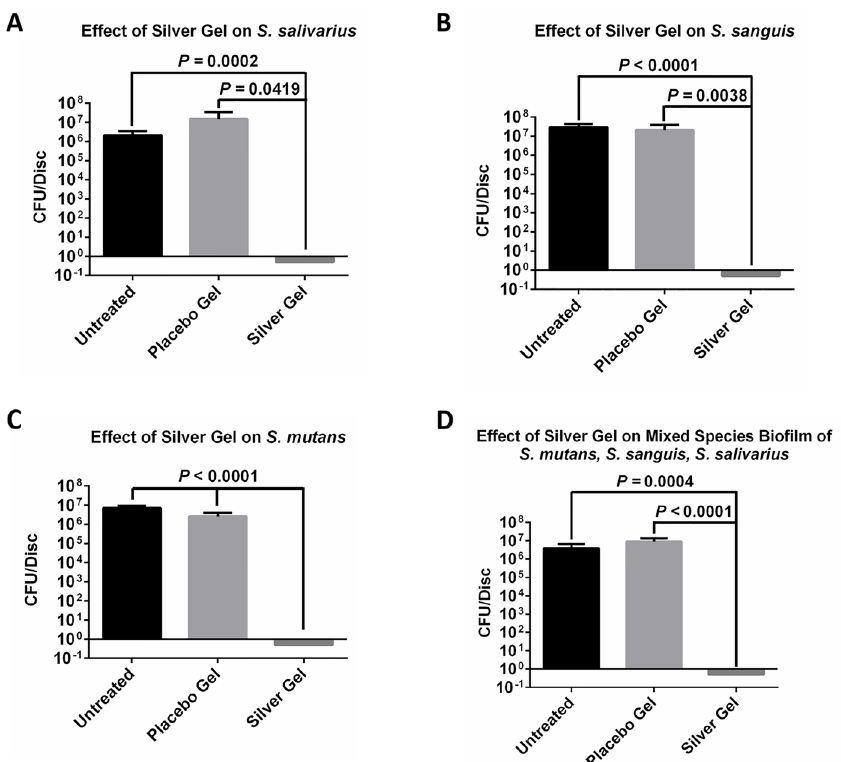
Figure 1. Colony forming unit analysis of biofilm formation. ( A ) S. salivarius , ( B ) S. sanguis, ( C ) S. mutans or ( D ) all three on untreated discs, discs treated with placebo gel or discs treated with colloidal silver